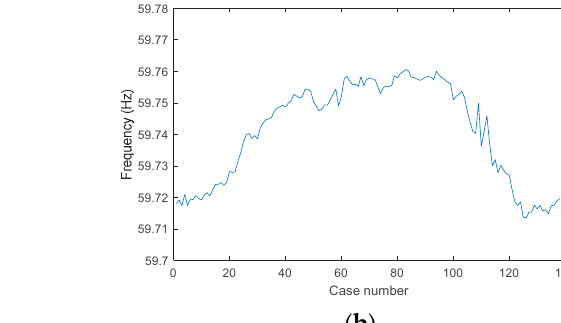
Figure 6. The overall structure of the technical approach.